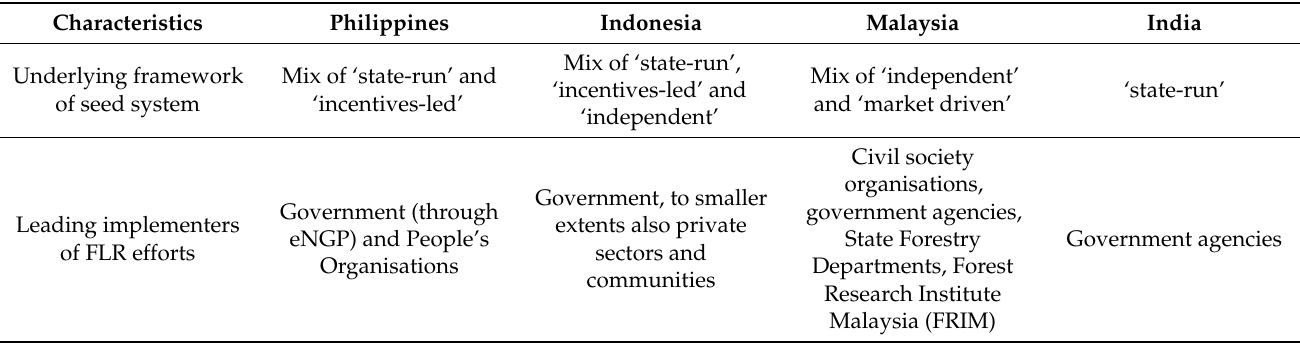
Table 3. Underlying framework for the national tree seed systems, focusing on the role of the government and leading implementers of FLR